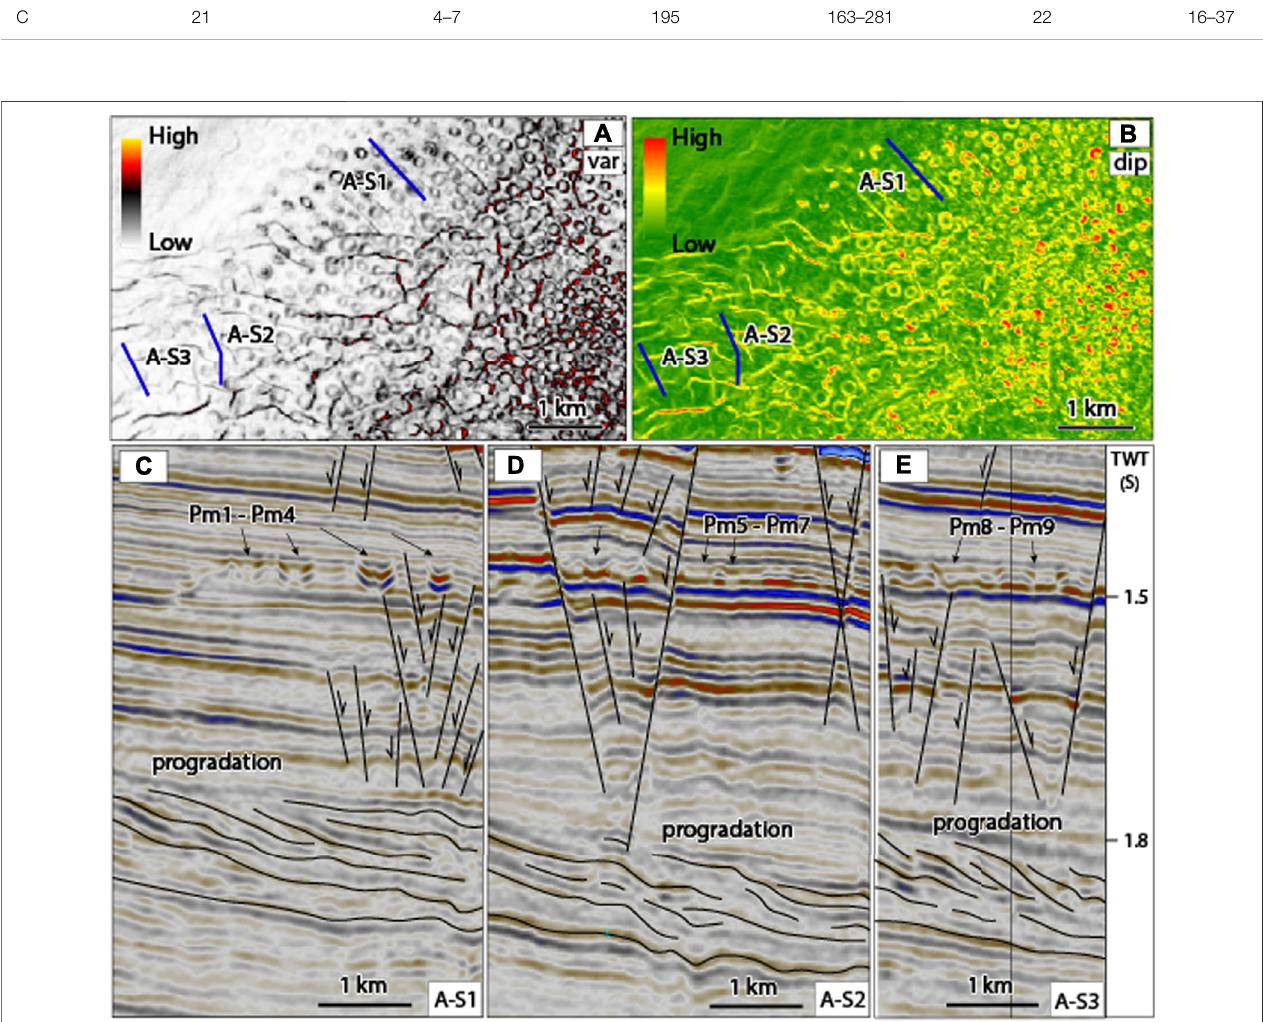
FIGURE 9 | (A) The variance map shows sub-round to round-shaped pockmarks on the top view with medium to high discontinuity values (0.5 – 0.8), while (B) the consistent dip map shows slope angles of paleo-pockmark walls between 7 and 15 ° (medium to high value). (C – E) Seismic sections A-S1 to A-S3 show the shape of ninepaleo-pockmarks(Pm1 — Pm9)inpro fi leview.Pm1andPm2areV-shapedpockmarks, whilePm3toPm9areU-shapedpockmarks.Theirsizerangesfrom204to 382 m width and 19 – 45 ms (TWT) depth.